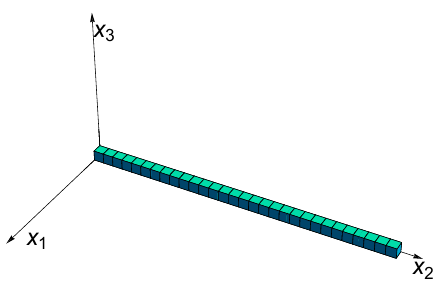
Figure 1 . The minimal representation corresponding to an in(cid:12)nite row in the x 2 direction. action (2.21), the set of all plane partitions (cid:3) indeed forms a faithful representation of the a(cid:14)ne Yangian algebra